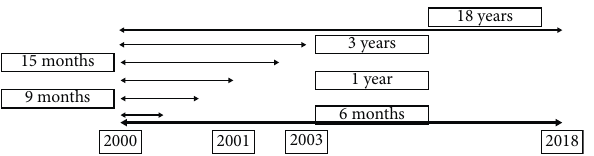
Figure 5: The timeline of time-series windows that we investigate within the study. We investigate the periods of economic turmoil as well as relatively stable periods. We also highlight here the truncation of 18 years, 3 years, 15 months, 1 year, 9 months, and 6